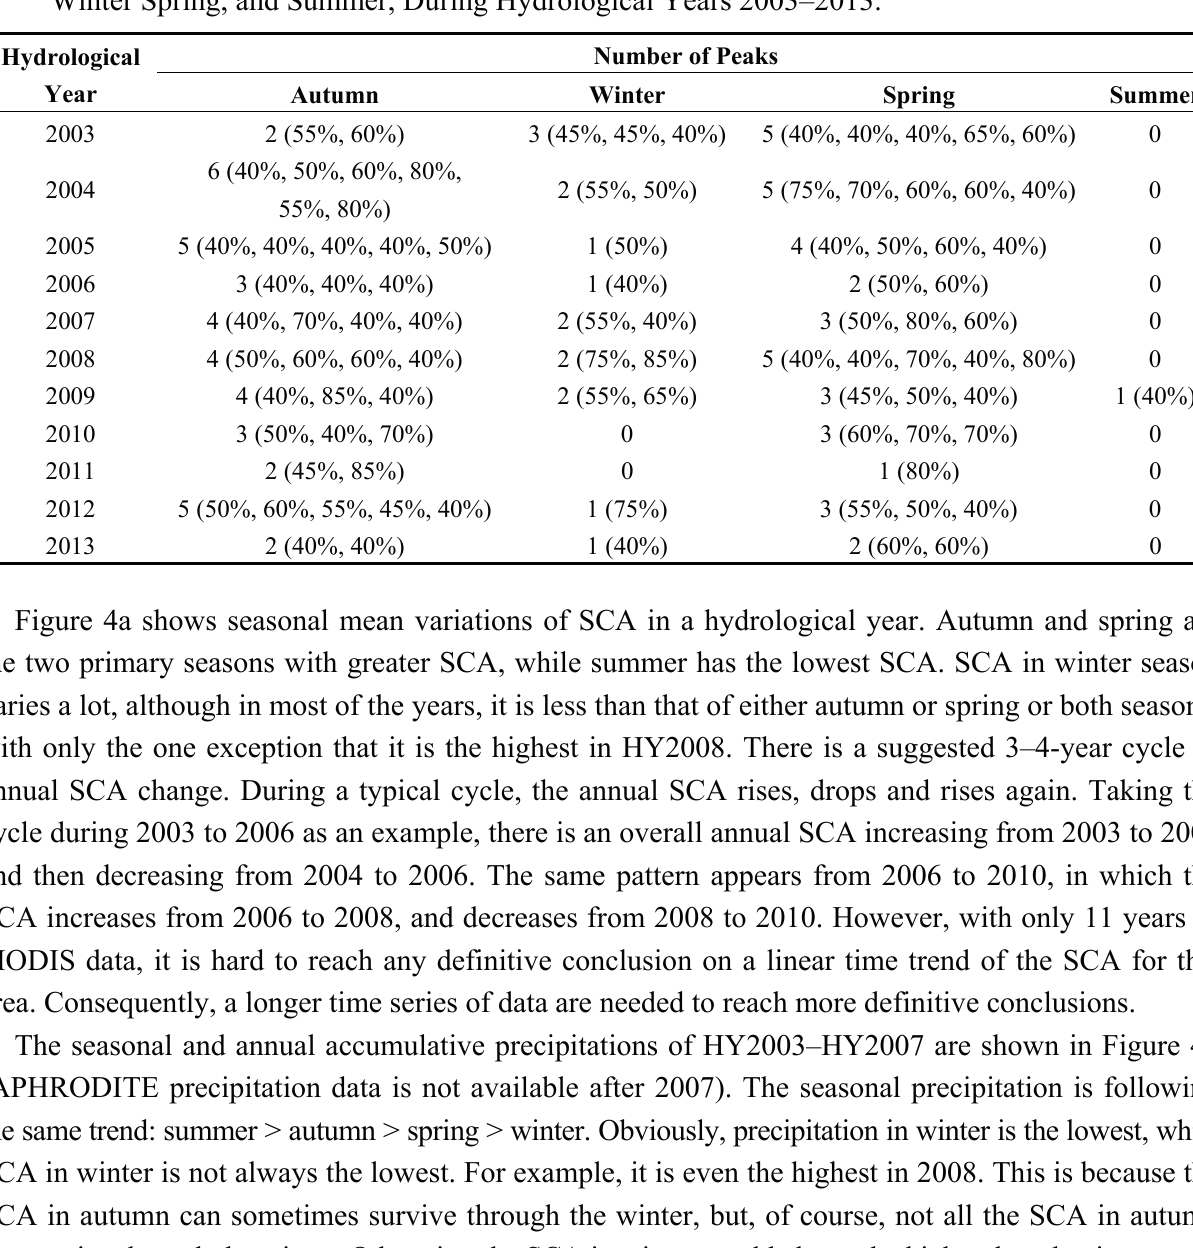
Table 1. Number of Peaks with Snow Cover Percentages of More Than 40% in Autumn, Winter Spring, and Summer, During Hydrological Years 2003–2013. Hydrological Year